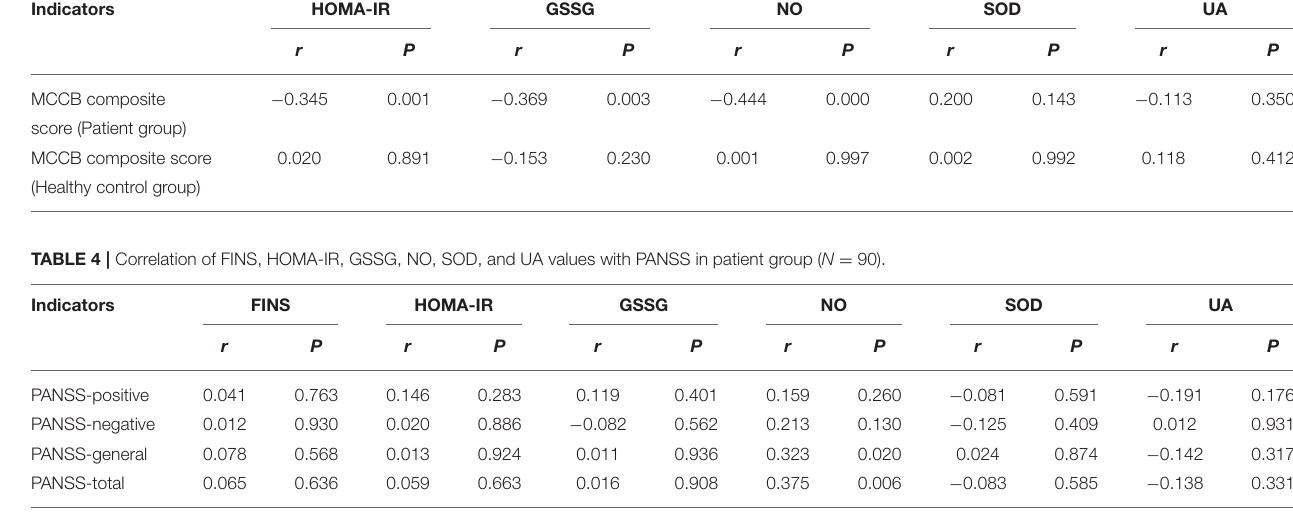
TABLE 3 | Insulin resistance, oxidative stress, and cognitive function. Indicators